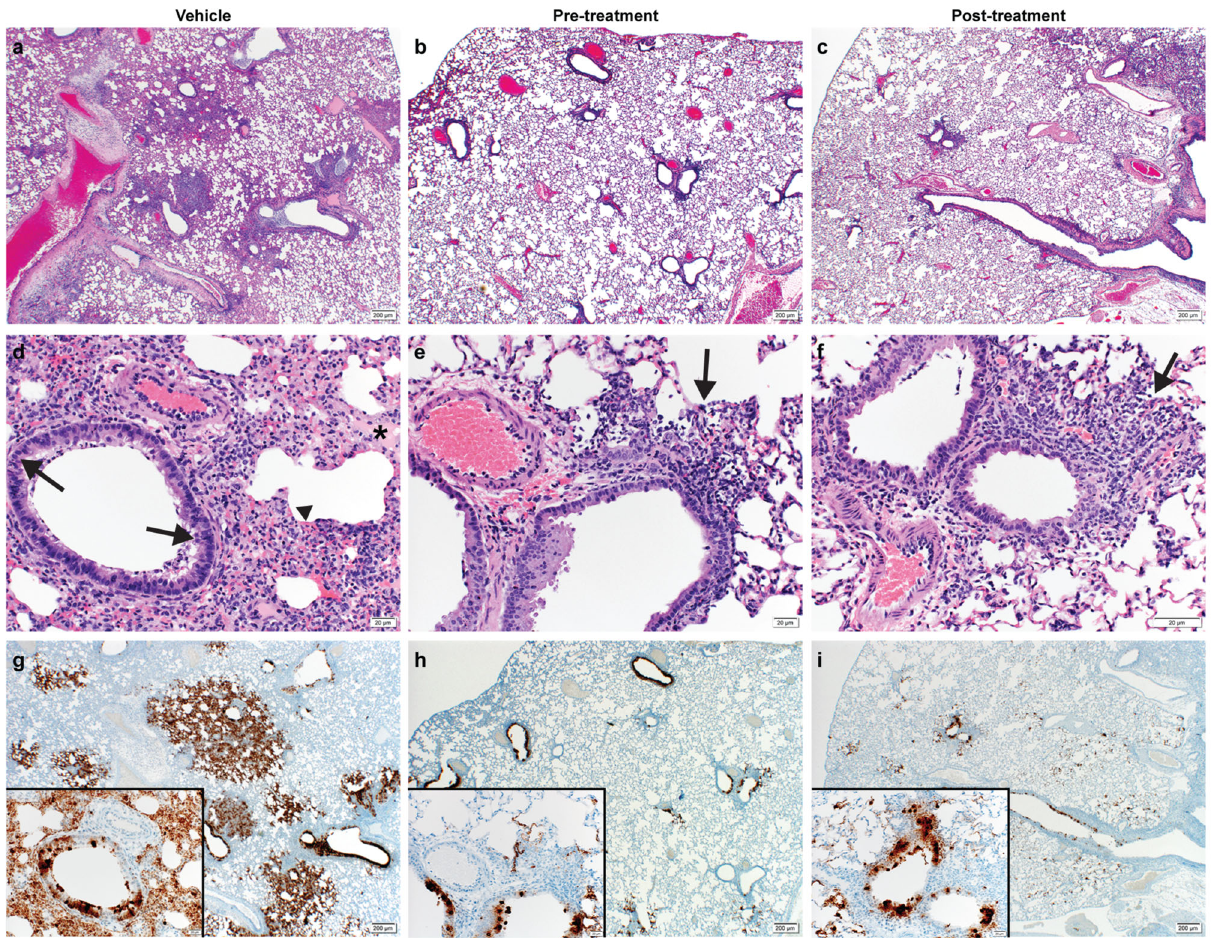
Fig. 3 Pathological analysis of the lung tissue. Hematoxylin and eosin (H&E) staining was used on lung sections to examine lung pathology post- inoculation. Immunohistochemistry (IHC) was used to detect viral antigen in the same lung sections from each animal ( N = 6 per group). a , d , g Untreated vehicle control, ( b , e , h ) pre-infection treatment with antiviral drug MK-4482 and ( c , f , i ) post-infection treatment with MK-4482. ( a – f ) H&E stain ( g , h , i ) IHC for SARS-CoV-2 nucleocapsid antibody. a Lung 20X: multifocal, moderate broncho-interstitial pneumonia. b , c Lung 20X: minimal peribronchial interstitial pneumonia. d Lung 200X epithelial cell necrosis (arrow), edema (asterisk), interstitial pneumonia (arrowhead). e , f peribronchial and interstitial in fi ltrates (arrow). g Lung 20X; insert 200X: numerous immunoreactive bronchiolar epithelial cells, type I and II pneumocytes and fewer macrophages. h, i Lung 20X; insert 200X: scattered to moderate numbers of immunoreactive bronchiolar epithelial cells, type I and II pneumocytes and macrophages. Pictures were taken in RGB color space (sRGB IEC61966-2.1) with a threshold set to 128. a – c , g – i Scale bar is 200 μ m. d – f Scale bar is 20 μ m.